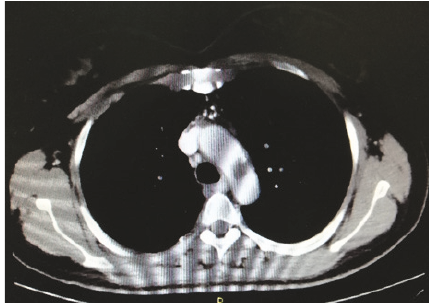
Figure 5: CT angiography revealed dislodgement of aortic throm- bus and occlusion of the left common femoral artery (Absence of contrast agent in the arterial phase).